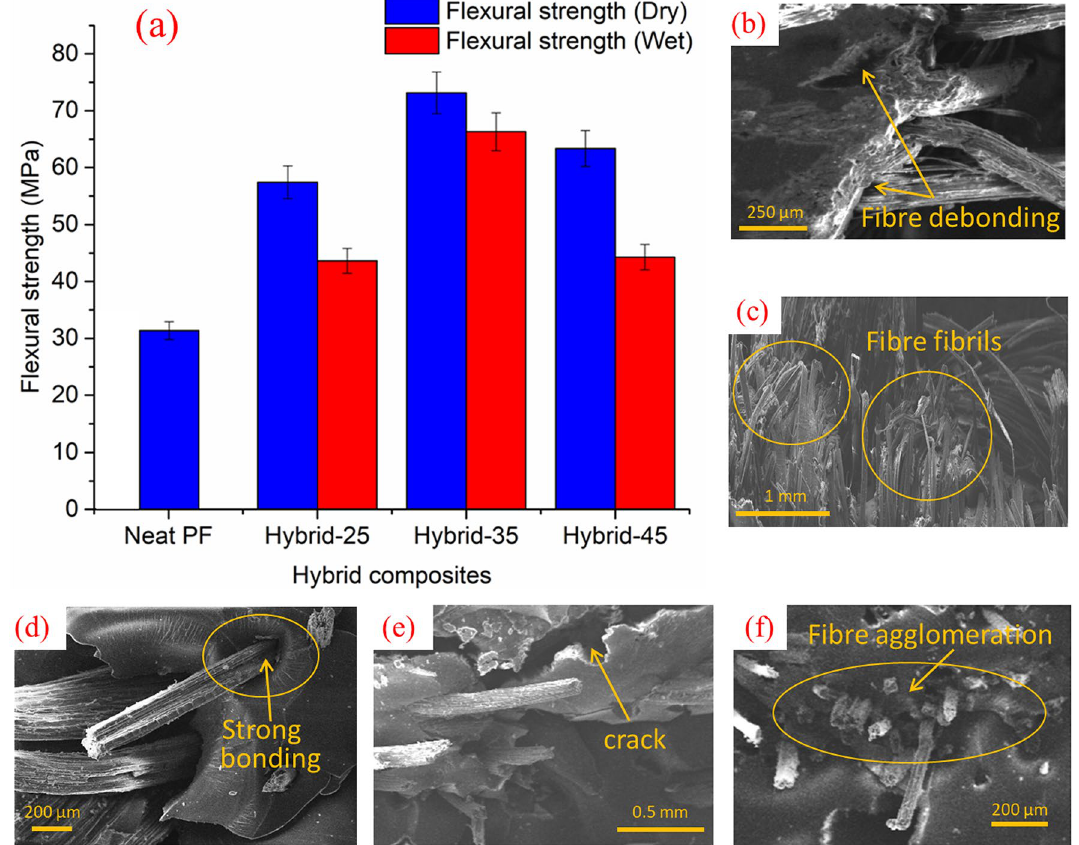
Figure 4. ( a ) Effects of water absorption on the flexural strength of CGF/AFF/PF hybrid composites based on the weight percentages of fibre. ( b , c ) SEM image of the fractured surface of the 35 wt.% hybrid composite after the flexural test (wet condition), ( d ) SEM image of the fractured surface of the 35 wt.% hybrid composite after the flexural test (dry condition), ( e , f ) SEM image of the fractured surface of the 45 wt.% hybrid composite after the flexural test (wet